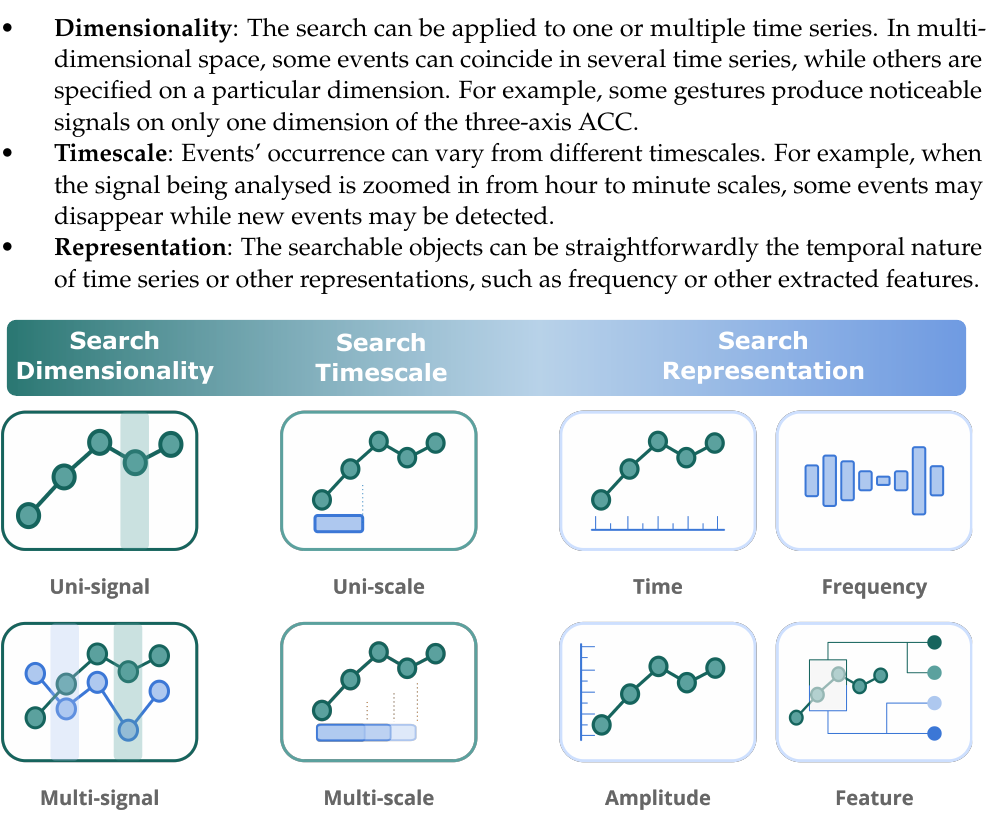
Figure 2. Event search in different ranks of dimensionality, timescales, and